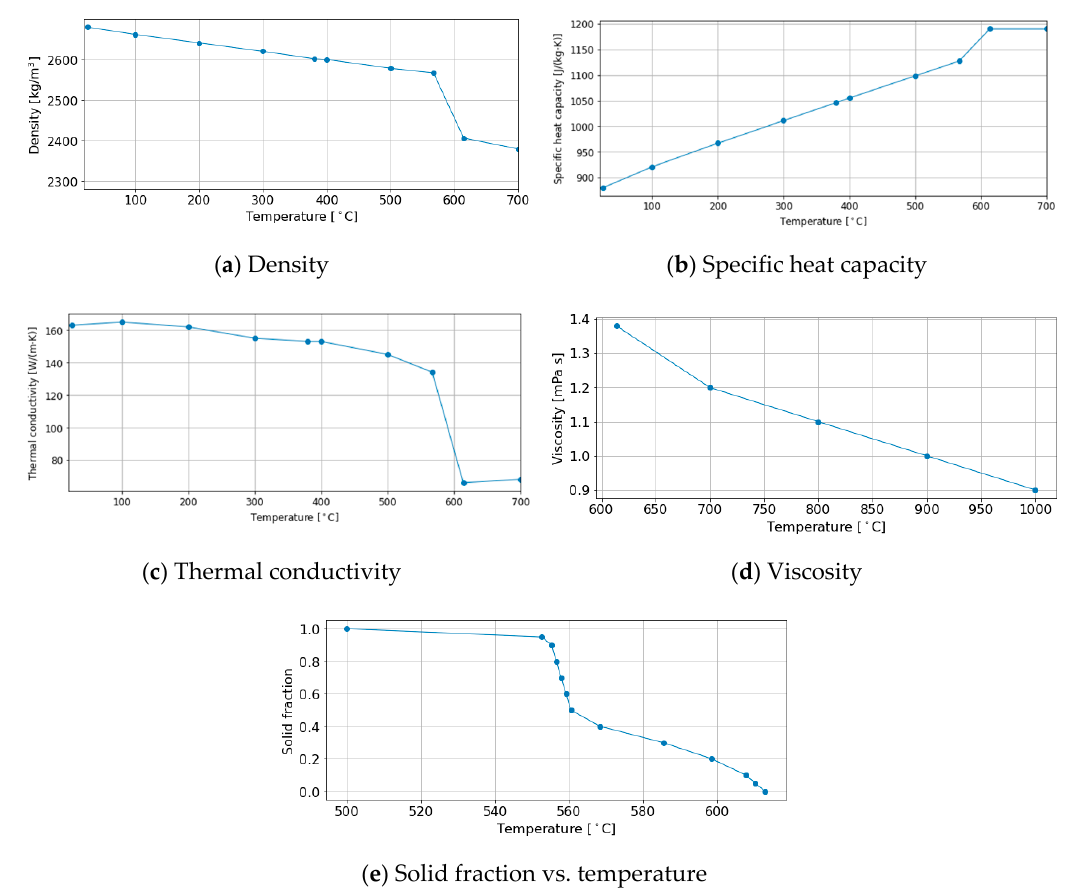
Figure 2. Temperature-dependent thermophysical properties of A356.